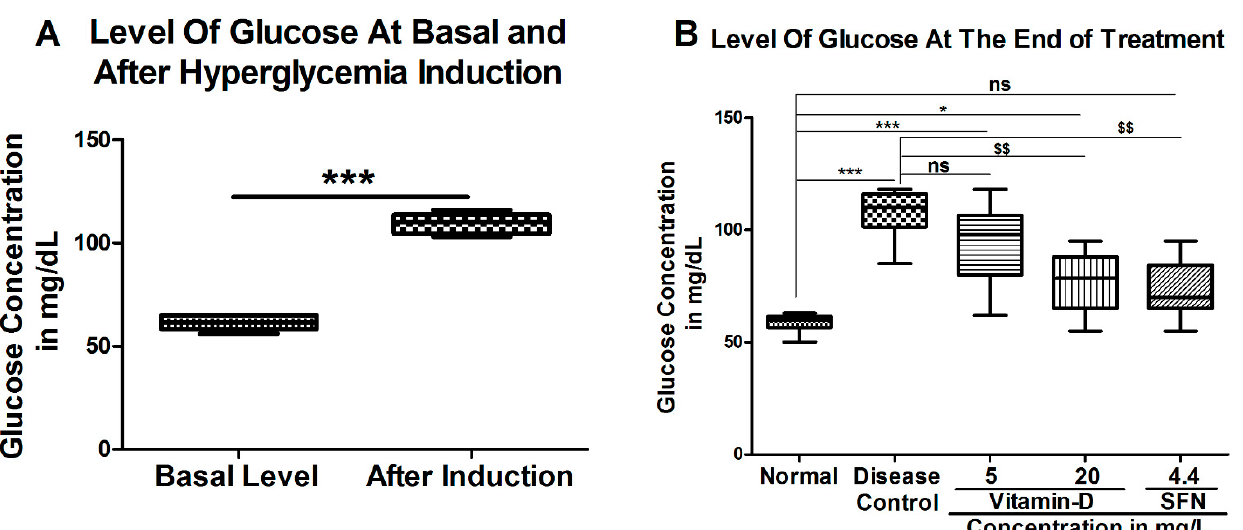
Figure 2. Vitamin D and SFN Reduced Blood Glucose in Diabetic Zebrafish. ( A ) Zebrafish developed hyperglycemia when grown in 111 mM glucose containing water. Data expressed as mean ( n = 6) ± SEM. Data were analyzed by one-way ANOVA, followed by Tukey’s posthoc test. In ( A ) “***” represents a significant difference in glucose level between the basal- (before glucose treatment) and post-induction (after glucose treatment) zebrafish with p < 0.0001. ( B ) High dose vitamin D and SFN reduced the blood glucose in hyperglycemic zebrafish. “***, *” Represents a significant difference between the normal control group and the other groups. p < 0.0001 & <0.05 respectively and “$$” represents a significant difference between disease control with vitamin-D and SFN treated groups p <0.001, “ns” represents ‘no significant difference.